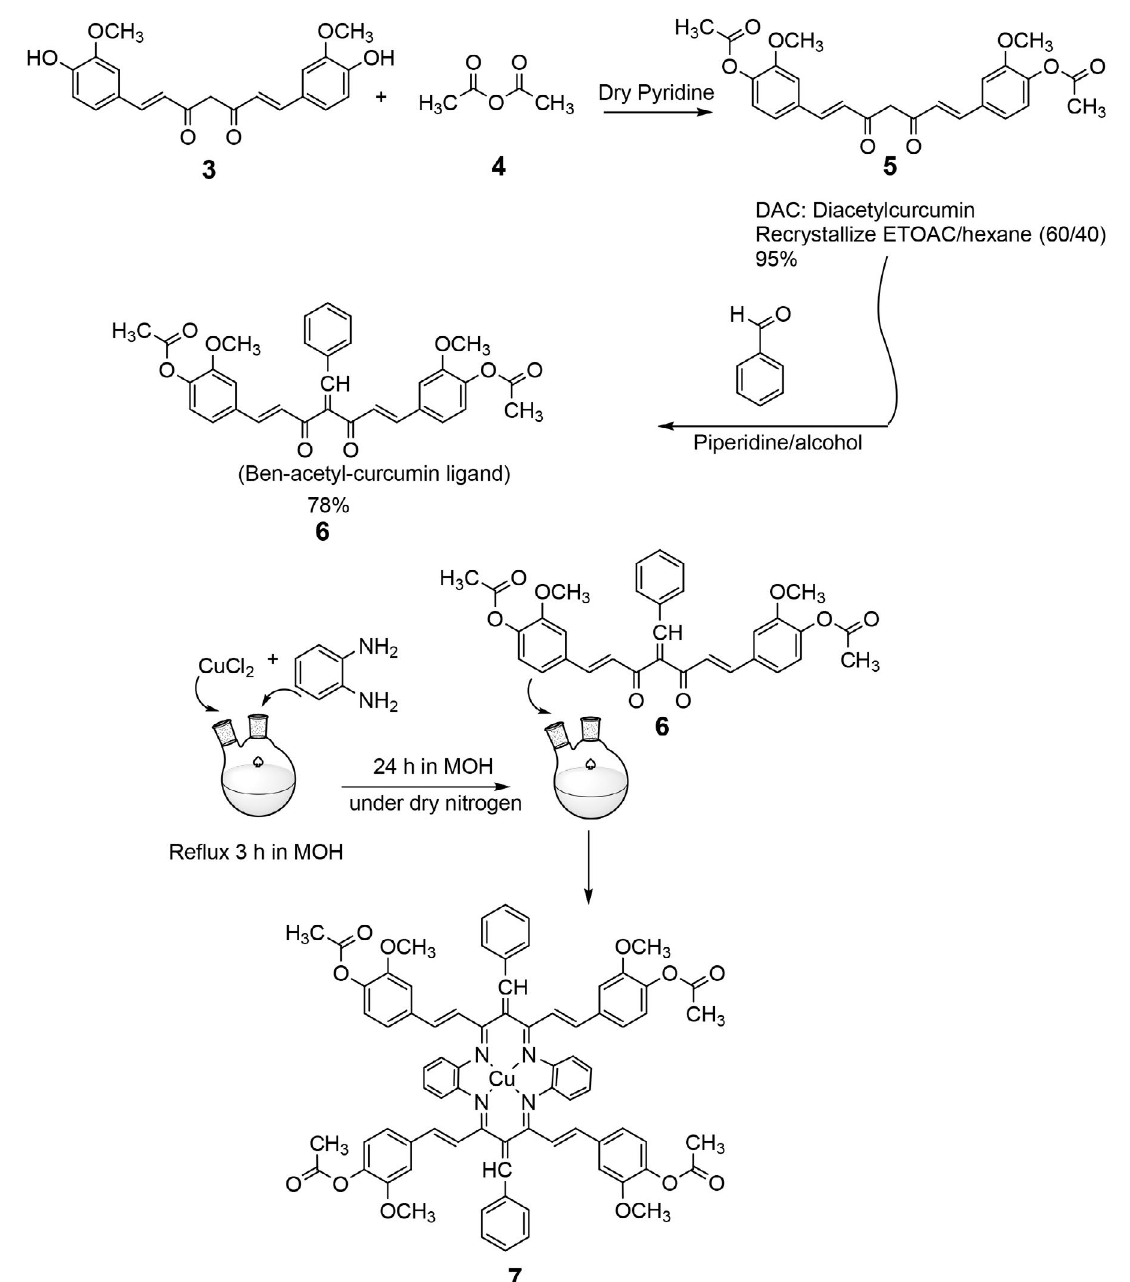
mmol) and SiO 2 -Cu-BDACDABSBC (0.05 mol %) in H 2 O at different temperatures, which afforded 2a in 51% yield (as the best result) after refluxing for 5 h (Table 1, entry 6). To study the influence of temperature and H 2 O, the model reaction was carried out at different temperatures (Table 1, entries 2–6). Due to Table 1, an increase in the temperature resulted in the promotion of cycloaddition reaction. The best result was obtained when the cycloaddi- tion reaction was conducted at 100 °C for 5 h (Table 1, entry